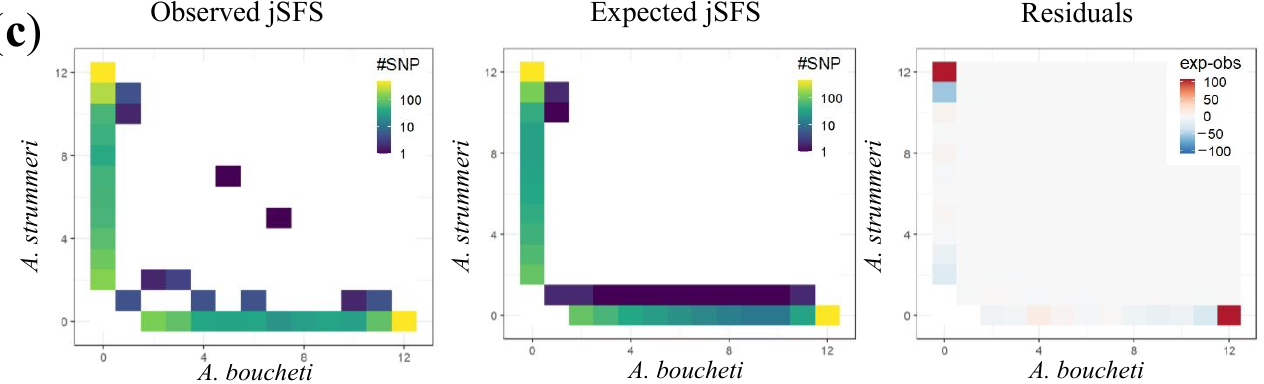
Figure 8. Comparison of the joint spectra of allele frequencies observed from the data (first column) and expected from the demographic model that provided the best fit in DILS (secondary contact with heterogeneous effective population size, second column) for the three pairs of species. The residuals (expected − observed) are displayed in the third column. ( a ) A. boucheti / A. kojimai ; ( b ) A. kojimai / A. strummeri ; ( c ) A. boucheti / A. strummeri . For the first pair of species ( a ), the position in the spectrum corresponds to the allele frequencies in A. kojimai (on the y -axis) and A. boucheti (on the x -axis), and the colour scale represents the number of SNPs with these allele frequencies. The white squares show an absence of SNPs having these allelic frequencies.